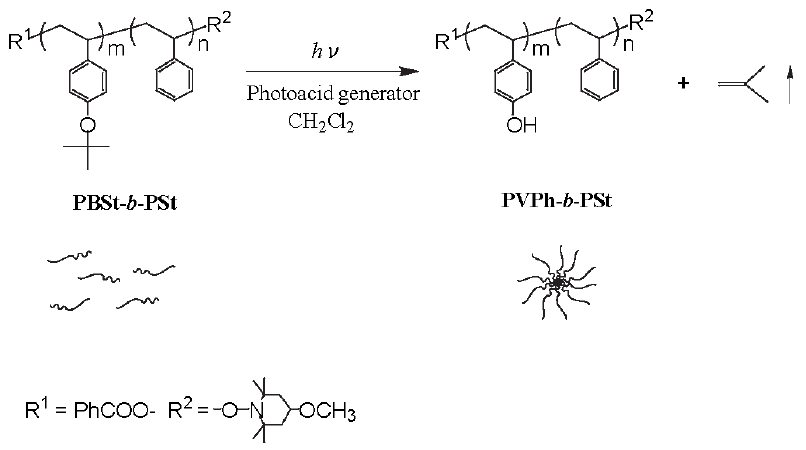
Scheme 2. Micellization induced by photolysis of PBSt- b